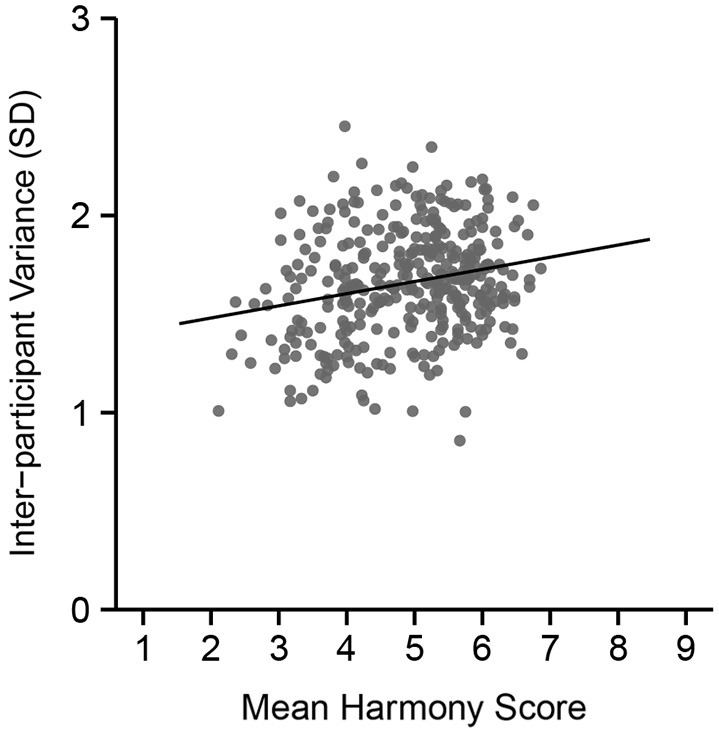
Inter-participant variance in color harmony score during the preliminary psychophysical experiment across mean harmony scores. The vertical axis indicates the size of the standard deviation in color harmony scores across the 18 participants.